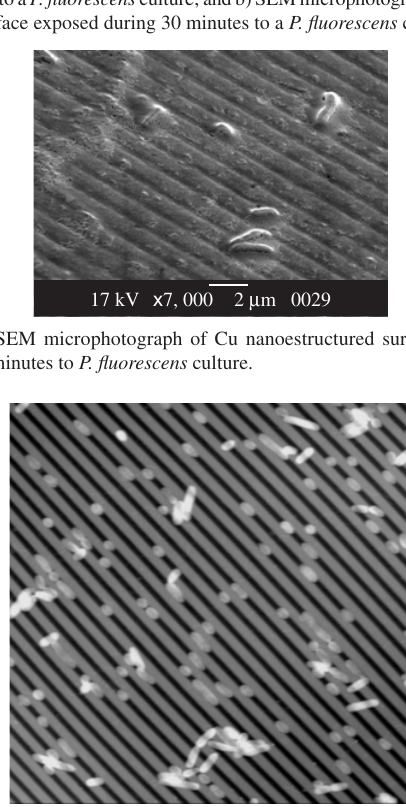
Figure 5. 40 µ m x 40 µ m contact mode AFM top view image of Au nanos- tructured surface exposed during 30 minutes to a culture of P. fluorescens